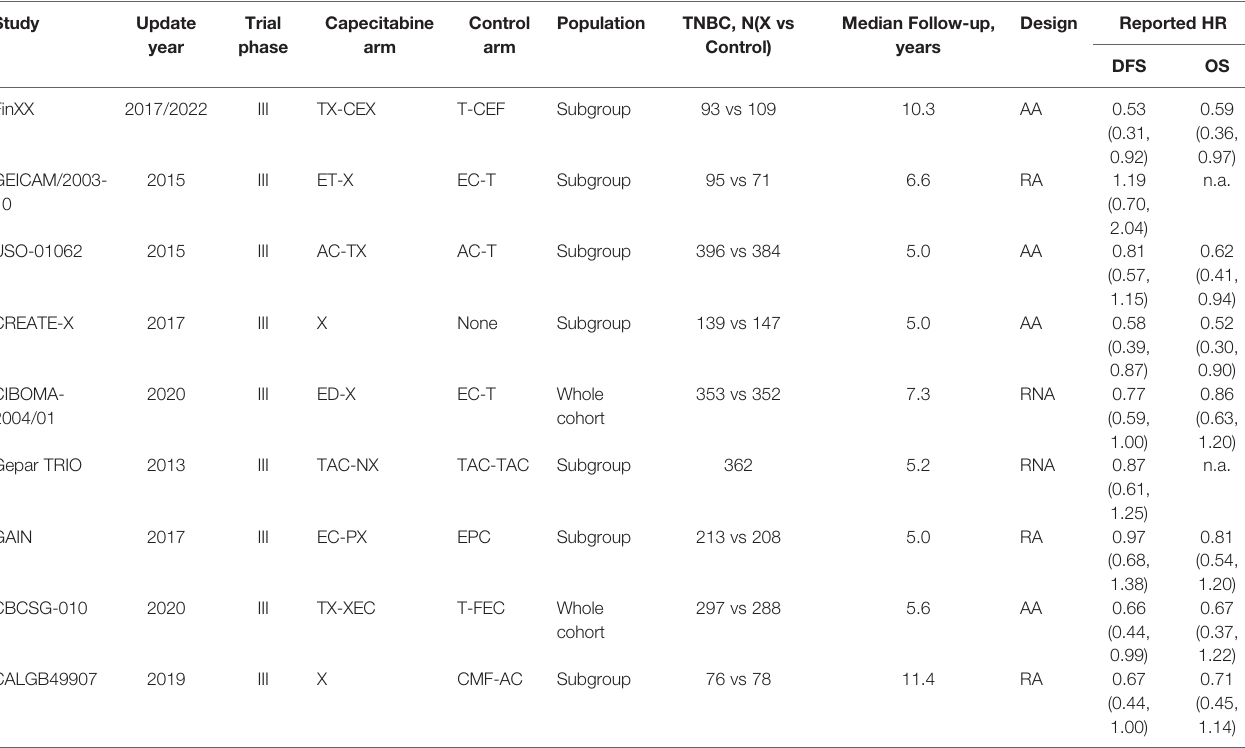
TABLE 1 | Basic characteristics of all eligible